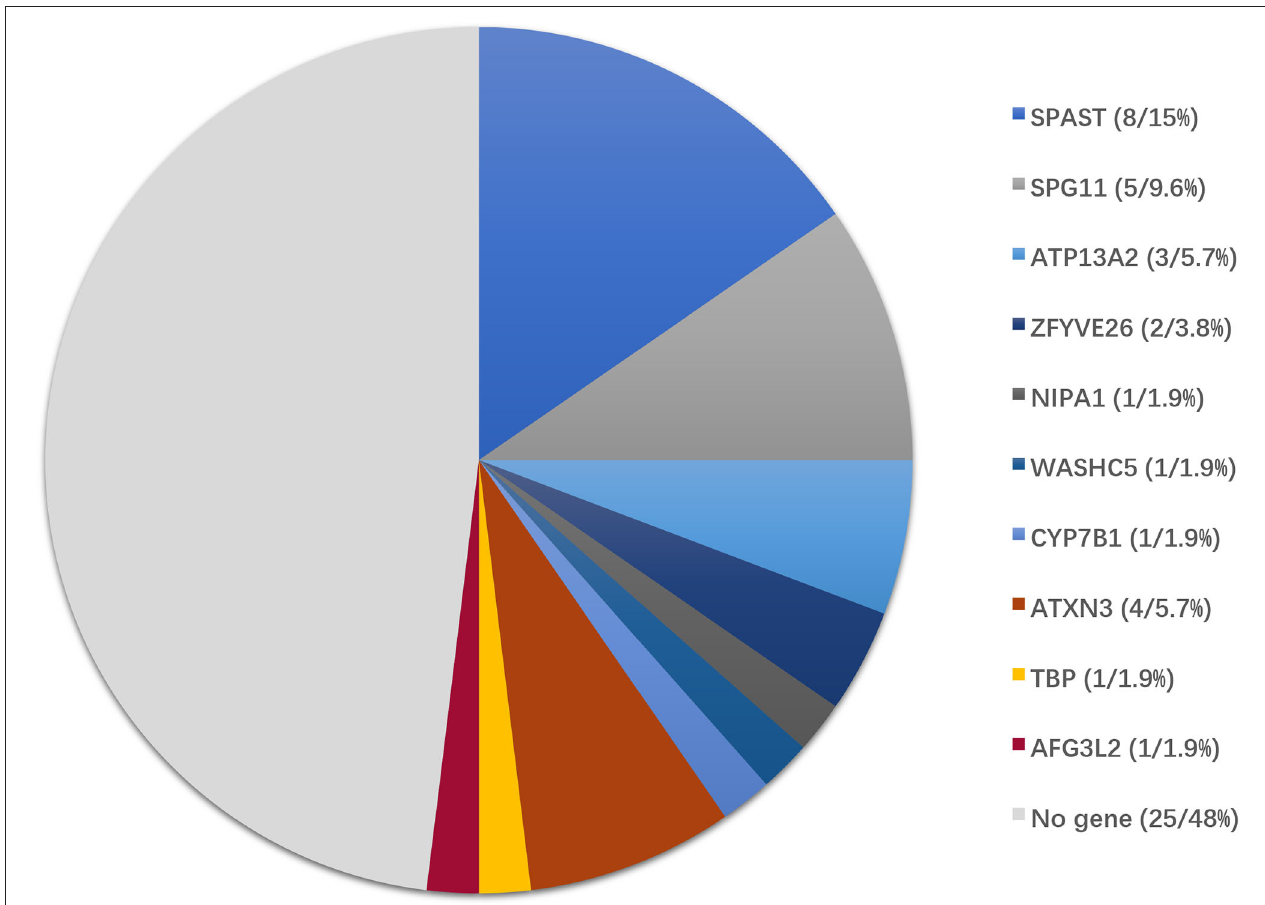
FIGURE 2 | Genotype distribution of patients enrolled in this study. Of 52 patients with clinically suspected HSPs, the final diagnoses were genetically confirmed in 27 patients by the genetic diagnostic